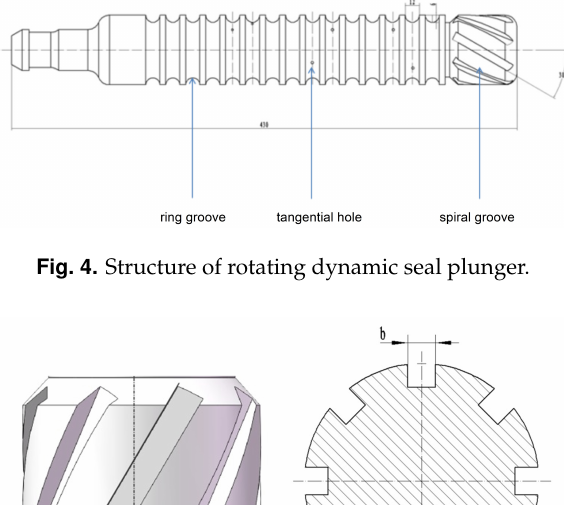
Fig. 3. Schematic diagram of conventional plunger eccentric wear and leakage problems.